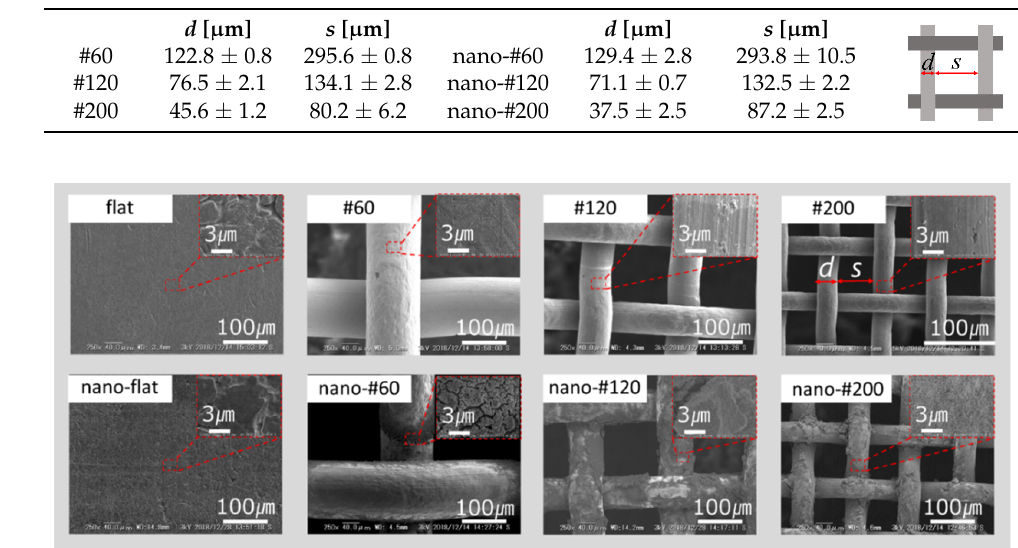
Figure 2. SEM images of test walls. Figure 2. SEM images of test walls. In addition, to prevent the mesh surfaces from undergoing thermal expansion, they Figure 2. SEM images of test walls. were fixed with the jig shown in Figure 1b. The jig consists of upper plates and a base Figure 2. SEM images of test walls. were fixed with the jig shown in Figure 1b. The jig consists of upper plates and a base plate, and the test walls can be fixed between them. Upper plate 1 was used for measuring plate, and the test walls can be fixed between them. Upper plate 1 was used for measuring the evaporation time, and upper plate 2 was used for high-speed imaging of the drop In addition, to prevent the mesh surfaces from undergoing thermal expansion, they impact. the evaporation time, and upper plate 2 was used for high-speed imaging of the drop were fixed with the jig shown in Figure 1b. The jig consists of upper plates and a base were fixed with the jig shown in Figure 1b. The jig consists of upper plates and a base plate, impact. plate, and the test walls can be fixed between them. Upper plate 1 was used for measuring and the test walls can be fixed between them. Upper plate 1 was used for measuring the the evaporation time, and upper plate 2 was used for high-speed imaging of the drop evaporation time, and upper plate 2 was used for high-speed imaging of the drop impact. The contact angle of the test walls was measured using the (cid:2016)/2 method. The contact impact. angles of the flat and nanoflat surfaces were (cid:2016) = 18.5 ± 0.1° and (cid:2016) = 5.5 ± 0.2°, respec- tively. Figure 3 shows the contact angle on the mesh surfaces. In the mesh surfaces, be- angles of the flat and nanoflat surfaces were (cid:2016) = 18.5 ± 0.1° and (cid:2016) = 5.5 ± 0.2°, respec- cause water penetrates the mesh, we measured the contact angle as a function of the angles of the flat and nanoflat surfaces were θ = 18.5 ± 0.1 ◦ and θ = 5.5 ± 0.2 ◦ , respectively. elapsed time. The contact angle of the test walls was measured using the (cid:2016)/2 method. The contact angles of the flat and nanoflat surfaces were (cid:2016) = 18.5 ± 0.1° and (cid:2016) = 5.5 ± 0.2°, respec- cause water penetrates the mesh, we measured the contact angle as a function of the penetrates the mesh, we measured the contact angle as a function of the elapsed time. tively. Figure 3 shows the contact angle on the mesh surfaces. In the mesh surfaces, be- elapsed time. cause water penetrates the mesh, we measured the contact angle as a function of the elapsed time.